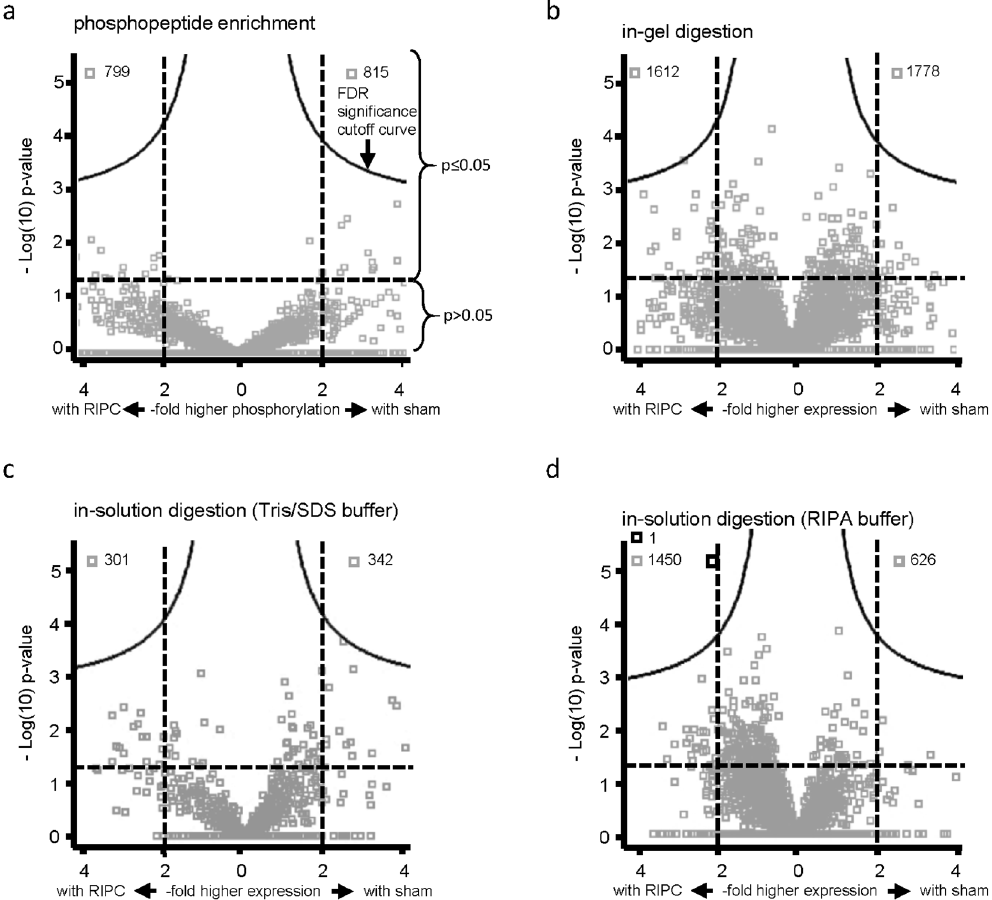
Figure 4. Vulcano plots of all detected proteins in the phosphoproteome/proteome analysis in human left ventricular biopsies. Vulcano plots of − Log(10)p-value over -fold higher phosphorylation/expression between groups (remote ischemic preconditioning (RIPC)/sham) of all proteins detected after ( a ) phosphopeptide enrichment, ( b ) in-gel digestion, ( c ) in-solution digestion of Tris/sodium dodecyl sulfate (Tris/SDS) and ( d ) radioimmunoprecipitation assay (RIPA) buffer-lysed human left ventricular biopsies taken at early reperfusion. A − Log(10)p-value of ≥ 1.3 corresponds to a p-value of ≤ 0.05. The false discovery rate (FDR) significance cut- off curve indicates only a significant increase of prostaglandin reductase 2 with RIPC than with sham in human biopsies lysed in RIPA buffer. Grey squares: phosphopeptides/proteins without FDR-based statistical difference between RIPC and sham. Black square: protein with FDR-based statistical difference between RIPC and